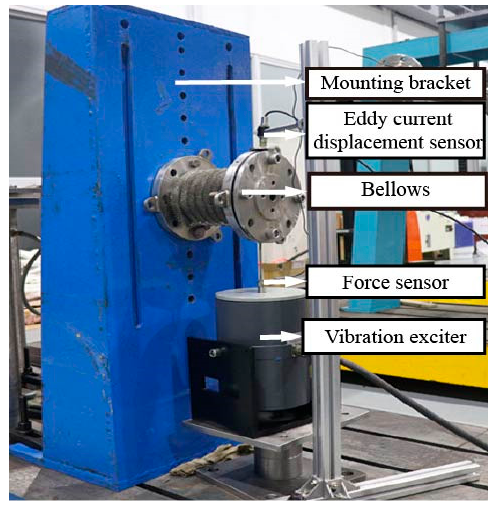
Figure 3. The test device. Figure 3. The test